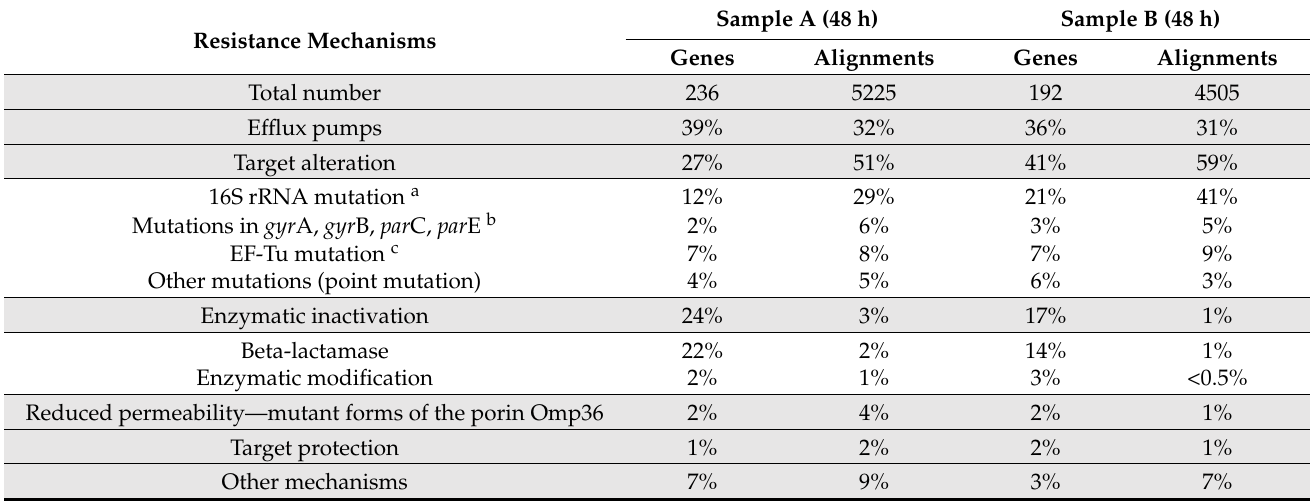
Table 6. Representation of individual mechanisms of resistance across detected ARGs, a —resistance to aminoglycoside, b —resistance to fluoroquinolones, c —resistance to